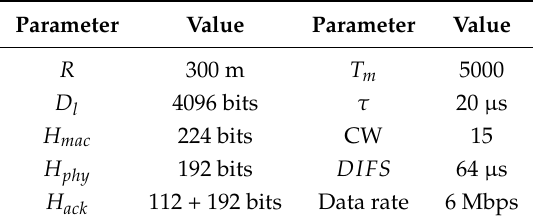
Figure 4. Simulation scenario: ( a ) real map; and ( b ) road topology. Table 1. Simulation